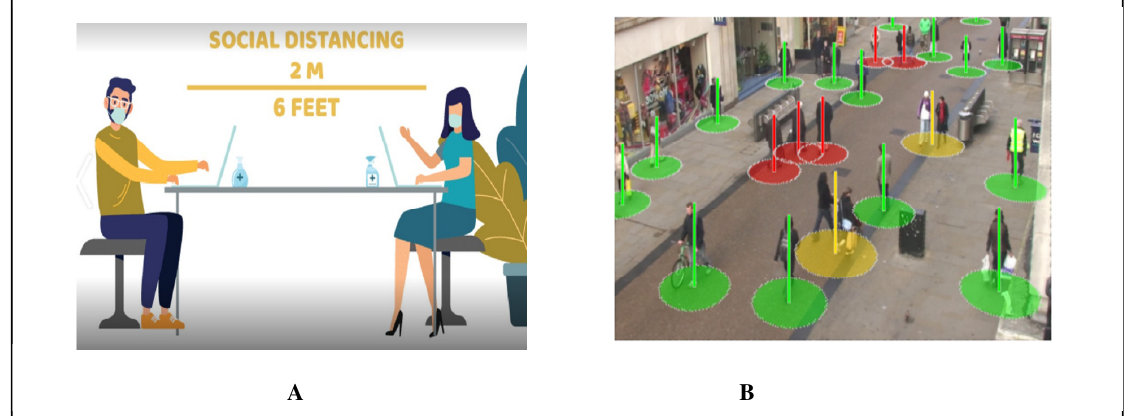
Fig. 1. A. Social distance must be between people [8]. B. Monitor social distancing